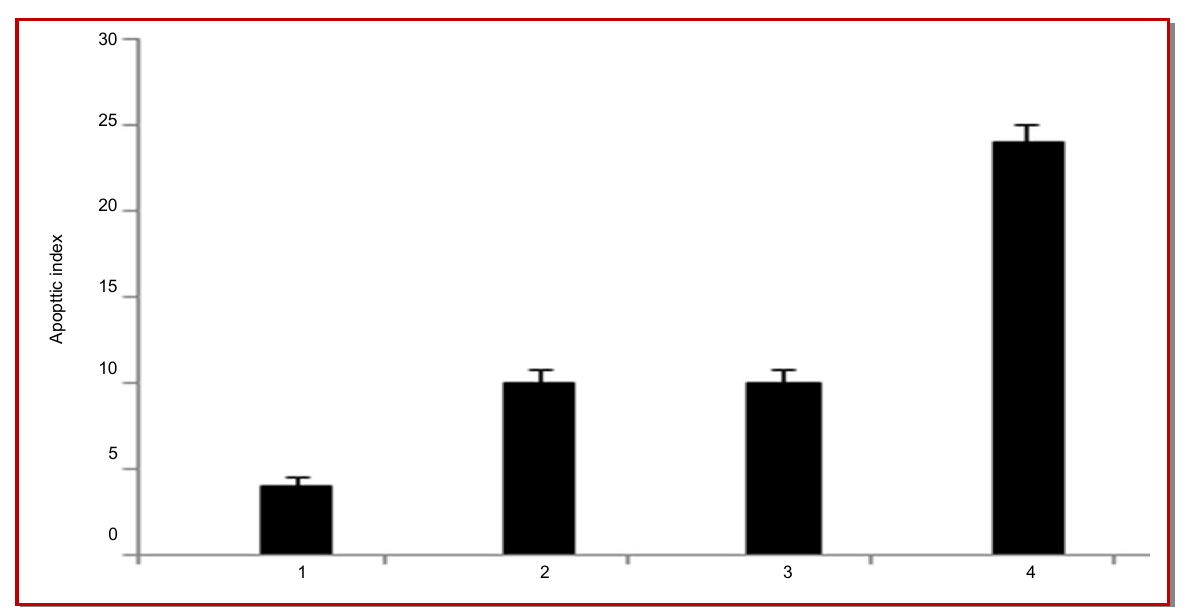
Figure 5: TUNEL assays of tumor tissue slides. The apoptotic index was significantly higher than that in the control, cerulenin and epirubicin alone indicated synergistic effect between the two. AI calculated for tumor tissues treated with a combination of cucurbitacin B and cerulenin (26.2 ± 8.4%) was higher than that of the tissues treated separately with cucurbitacin B (14.5 ± 6.8%) or cerulenin (12.6 ± 7.5%). The AI for untreated tumor tissues was 4.2 ± 1.5%.